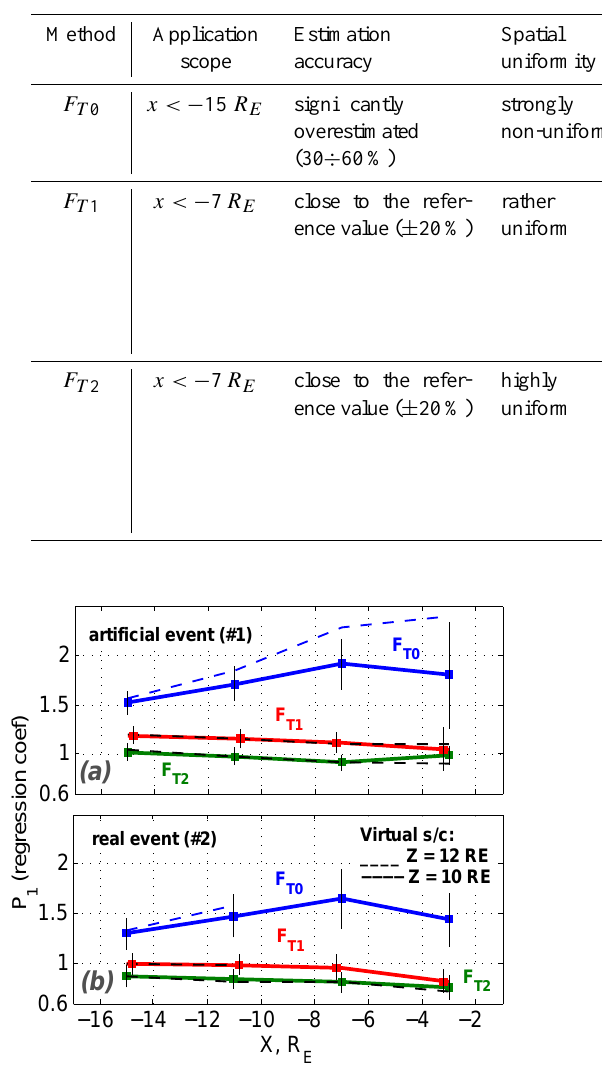
Figure 7. The value of the regression coefficient P 1 in F T 0 ( 1 , 2 ) = P 1 F MHD for different observation points: T x = − 15 , − 11 , − 7 , − 3 R E , y = 0 and z = 10 , 12 R E . Results are shown for both artificial event ( a ) and real event ( b ) simula- tions. Vertical bars denote the confidence